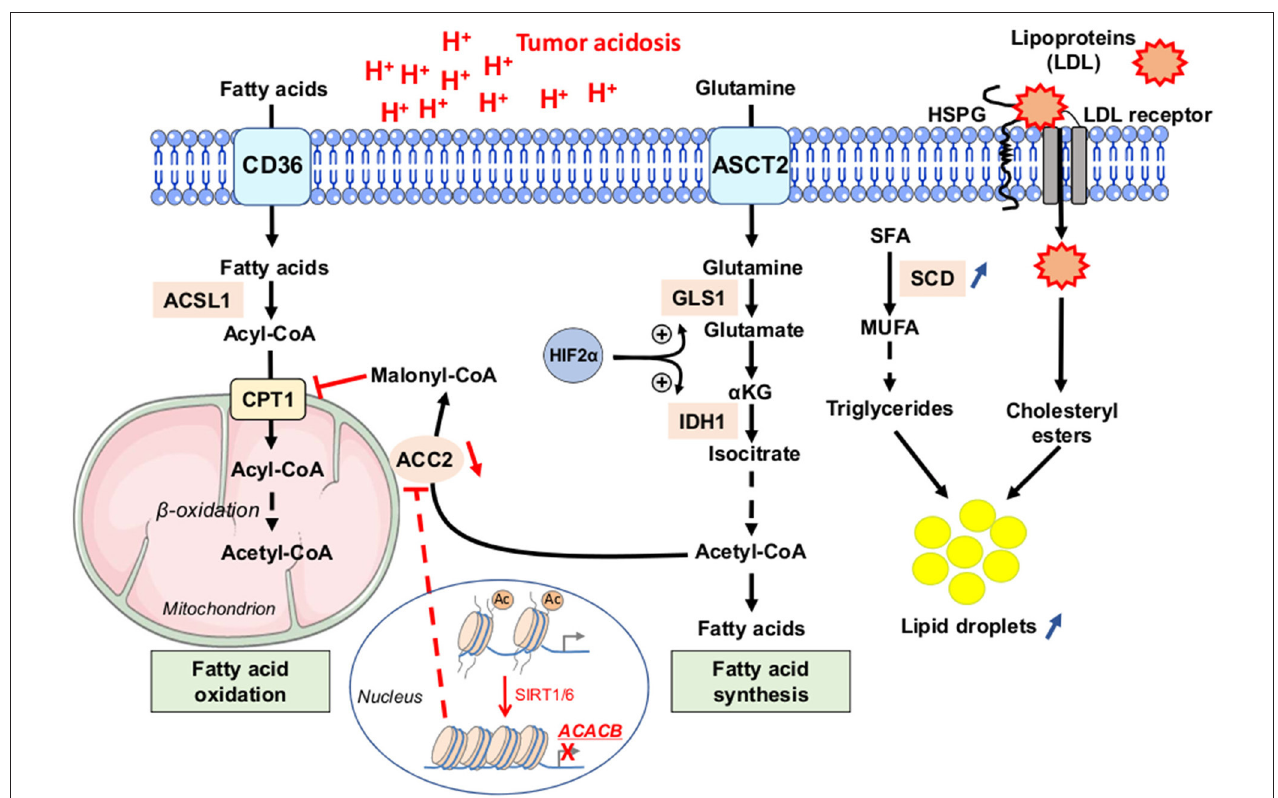
FIGURE 5 | Fatty acid metabolism dysregulation as a phenotypic feature of cancer cells under acidic conditions. Tumor cells, exposed to low pH conditions, exhibit profound alterations in lipid metabolism, with a concomitance of fatty acid oxidation (FAO) in mitochondria and synthesis from glutamine (FAS) in the cytoplasm rendered possible through a sirtuin 1 and 6 (SIRT1/6)-mediated downregulation of the acetyl-CoA carboxylase 2 (ACC2). Saturated fatty acids (SFA) can be actively transformed by stearoyl-CoA desaturase enzyme (SCD) into mono-unsaturated FA (MUFA), and then into triglycerides. Acidosis-exposed tumor cells also increase lipoprotein uptake in a heparan sulfate proteoglycan (HSPG)-dependent manner. Increased accumulation of neutral lipids (i.e., triglycerides or LDL particle-derived cholesteryl esters) into lipid droplets is observed in cancer cells under acidic pH conditions. Ac, acetyl group; ACSL1, long-chain fatty acid CoA ligase 1; ASCT2, alanine serine cysteine-preferring transporter 2; CD36, cluster of differentiation 36; CPT1, carnitine palmitoyl transferase 1; GLS1, glutaminase 1; IDH1, isocitrate dehydrogenase 1; LDL, low-density